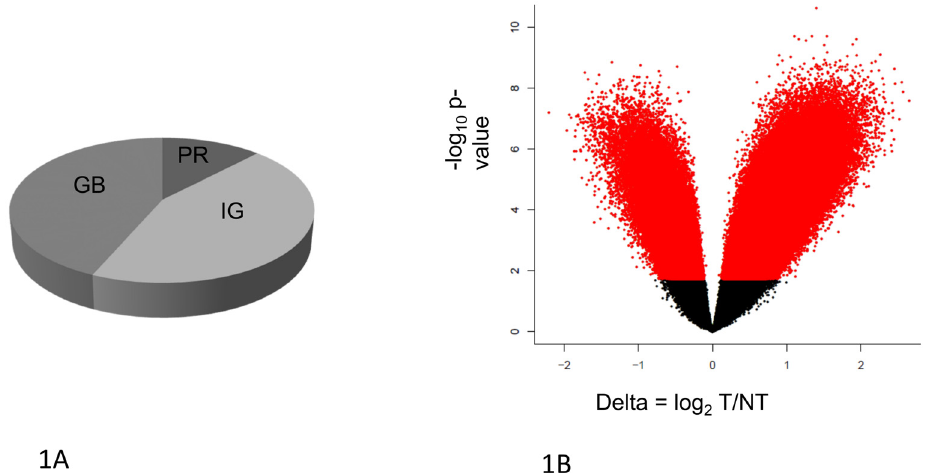
Fig 1. The genome compartment represented on the HELP Nimblegen microarray and statistically significant DM loci. (A) Approximately 91% of the 1.2 million loci represented on the HELP microarray are located in gene body (GB) and intergenic (IG) regions, with a small minority (9%) of the loci located within promoters (PR). (B) Statistical significance (Y-axis) vs. delta (X-axis) (magnitude) of DM. Delta (X-axis) indicates the difference in methylation between tumor (T) vs non-tumor (NT) at a given locus. Loci hypermethylated in T relative to NT have delta < 0. P-value (Y-axis) is calculated based on Benjamini Hochberg adjusted FDR. At FDR p < 0.05, 433,505 loci across all genomic compartments are found to be differentially methylated in T vs NT. Red dots indicate statistically significant DM